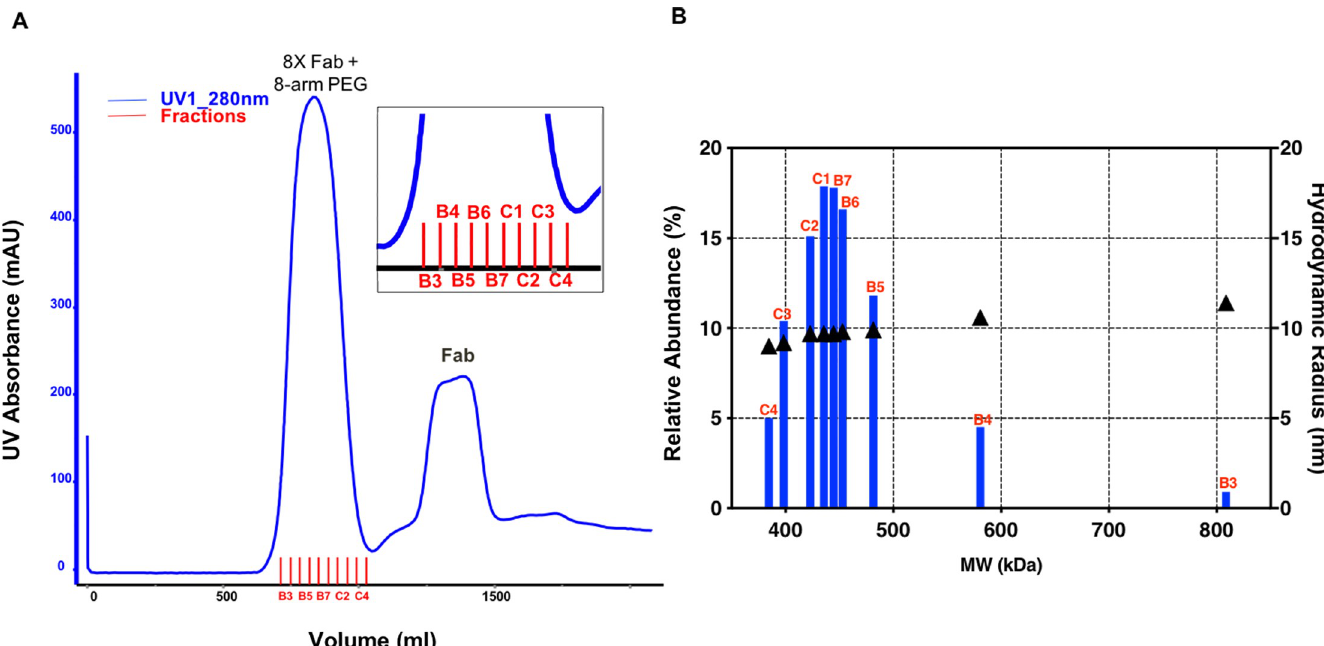
Fig 3. A. Example of purification chromatogram for scale-up production of 8-arm conjugate. An S-400 column was used to isolate each conjugation mixture and remove unreacted species. B. Fractions across the main peak were analyzed, by SEC-MALS to determine MW (x-axis) and by SEC-QELS (right y-axis) to determine R H . Additionally, these values were compared to each other based on their relative abundance (left y-axis). Analysis of the conjugation product reveals a gaussian distribution of MWs, with the greatest abundance centered around the desired specification based on Table 2. It is interesting to note that the measured R H values do not change appreciably despite a wide range of MWs.